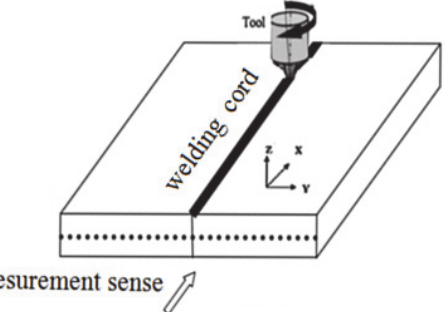
Figure 8: Profile of welded joint on half